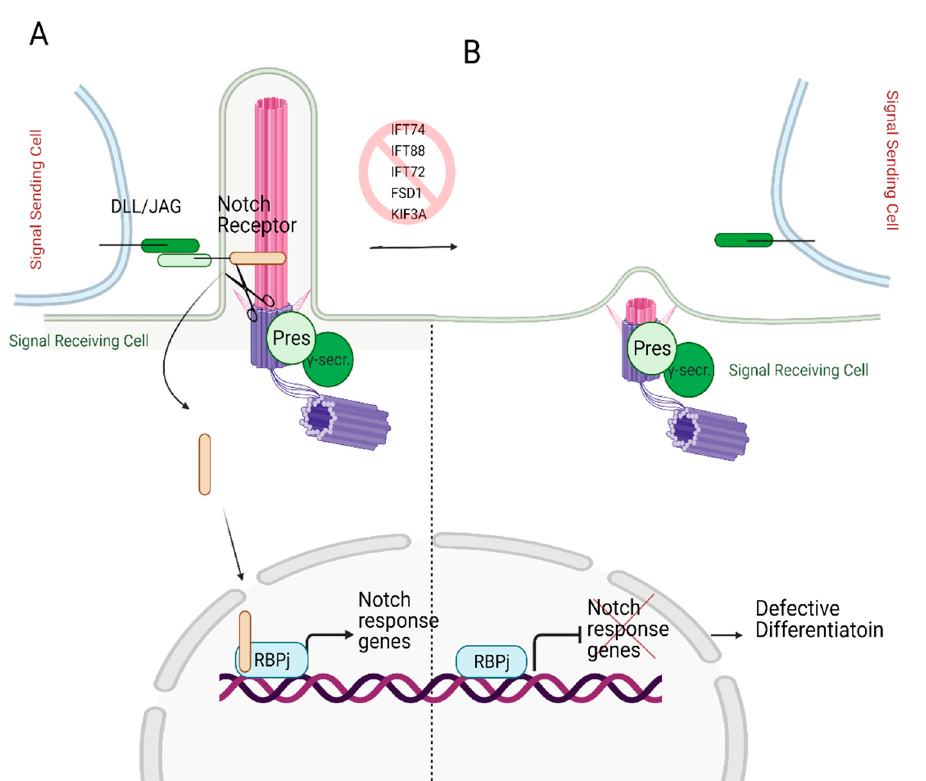
Figure 6. Role of primary cilia in Notch signaling. ( A ) Notch receptor localizes on the primary cilium. Following the binding of the Notch receptor to the ligands DLL/JAG, NICD is cleaved by presenilin (Pres), the catalytic subunit of γ -secretase, which localizes on the basal body. Cleaved NICD translocates to the nucleus. It serves as a transcriptional co-activator of the RBPj (Recombination signal Binding Protein for immunoglobulin kappa j region) to express Notch response genes. ( B ) In the absence of primary cilia, expression of Notch target genes is halted since Notch receptor cannot localize to the ciliary membrane and be cleaved by presenilin, resulting in defective differentiation. Created with BioRender.com.